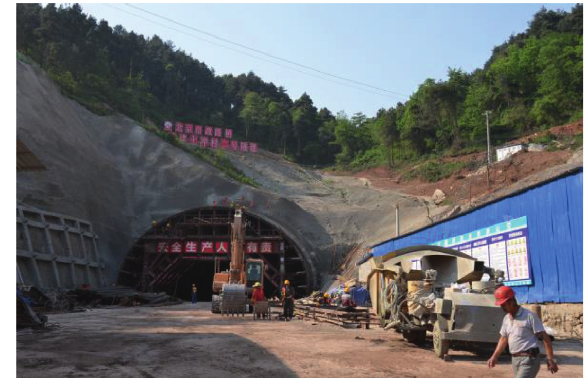
Figure 1: Overview of the tunnel.